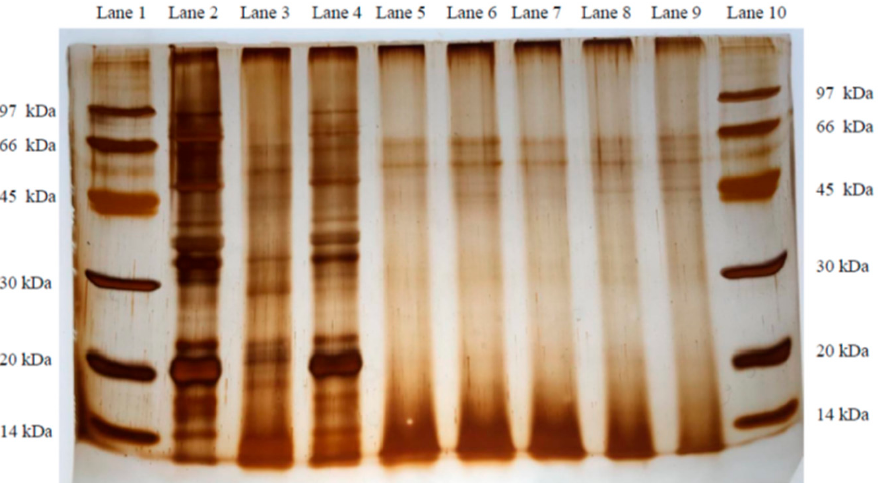
Figure 1. Glycine SDS-PAGE of soybean meal, meat and bone meal, MSM, and different Bacillus spp. FMSMPs. Lanes 1 and 10: Maker. Lane 2: Soybean meal. Lane 3: Meat and bone meal. Lane 4: Unfermented meat and bone meal–soybean meal (MSM). Lane 5: Fermented meat and bone–soybean meal product (FMSMP) inoculated with Bacillus subtilis var. natto N21. Lane 6: FMSMP inoculated with Bacillus siamensis M3. Lane 7: FMSMP inoculated with Bacillus velezensis M5. Lane 8: FMSMP inoculated with Bacillus subtilis . M6 Lane 9: FMSMP inoculated with Bacillus subtilis M20.